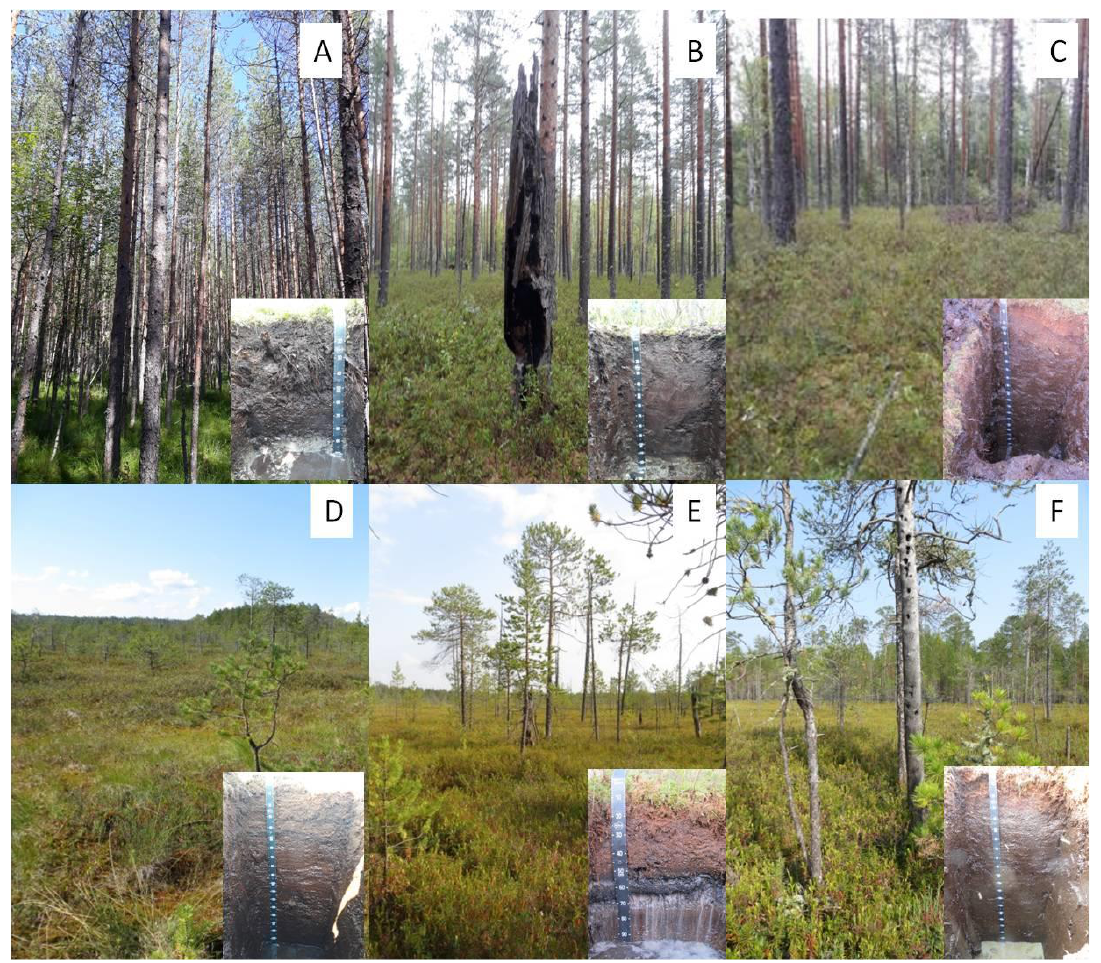
Figure 2. The vegetation and the structure of the soil profile. ( A ) — Site 0 (Maksimovsky monitoring site, Komi Republic), ( B ) — Site I (Koygorodsky National Park, Komi Republic), ( С ) — Site II (Pe- site, Komi Republic), ( B )—Site I (Koygorodsky National Park, Komi Republic), ( C )—Site II choro-Ilychsky Reserve, Komi Republic), ( D ) – Site III (Zotino, Krasnoyarsk Region), ( E ) — Site IV (Zotino, Krasnoyarsk Region), ( F ) — Site V (Zotino, Krasnoyarsk Region). Site I is located near the Koygorodsky National Park (Komi Republic; 59°58 ′ 58 ″ N, 50°09 ′ 24 ″ E). A soil pit (№ 10– 19) was made at the wooded edge of the mire (Figure 2B).